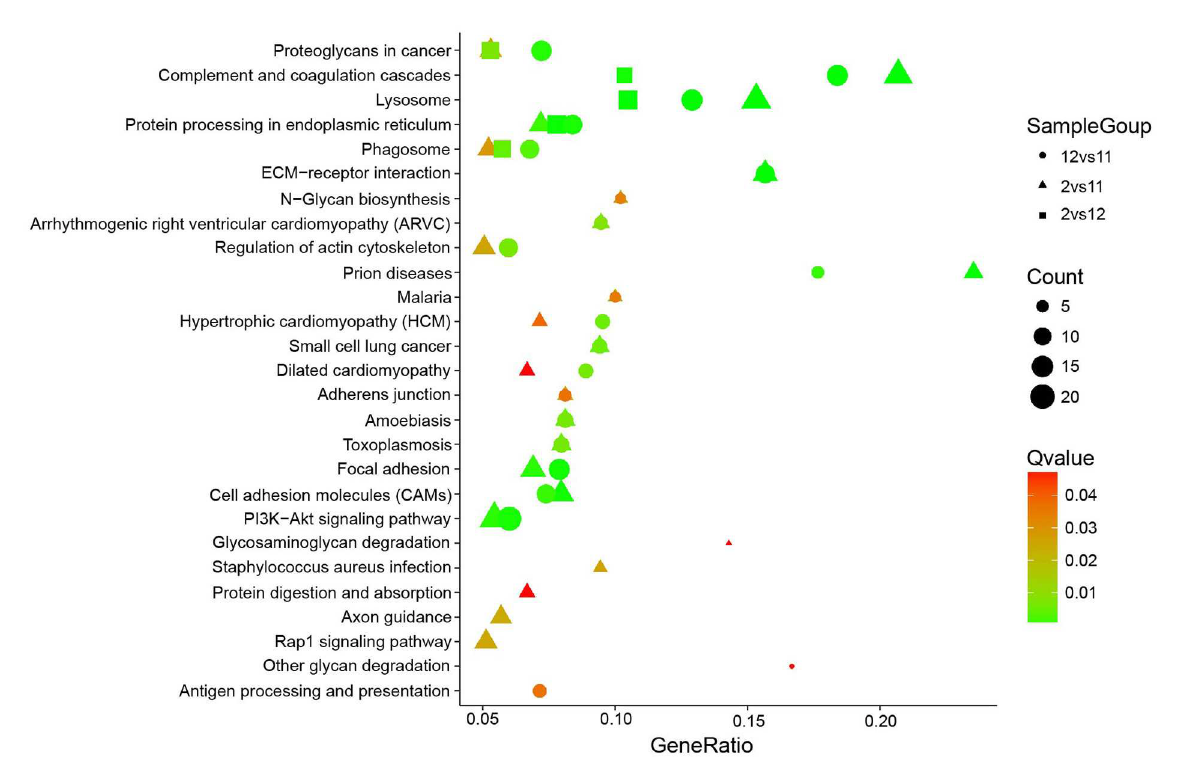
FIGURE6 KEGG pathway analysis for differentially expressed mink testicular N-glycoproteins at different stages. The y-axis represents the name of the